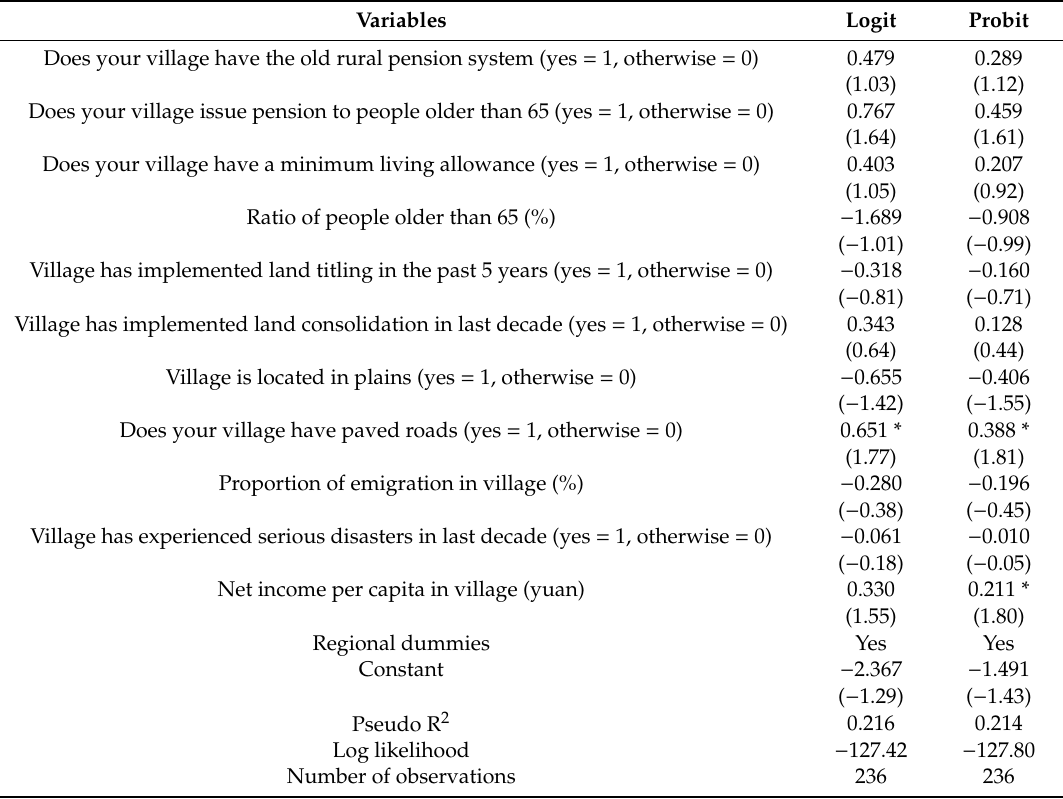
Table 3. Determinants of the NRPS at the village